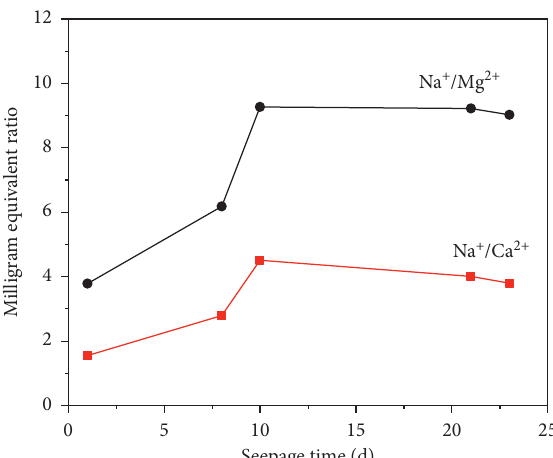
Figure 4: Variation of Na + /Ca 2+ and Na + /Mg 2+ (milligram equivalent ratio) in the exudate during different periods.